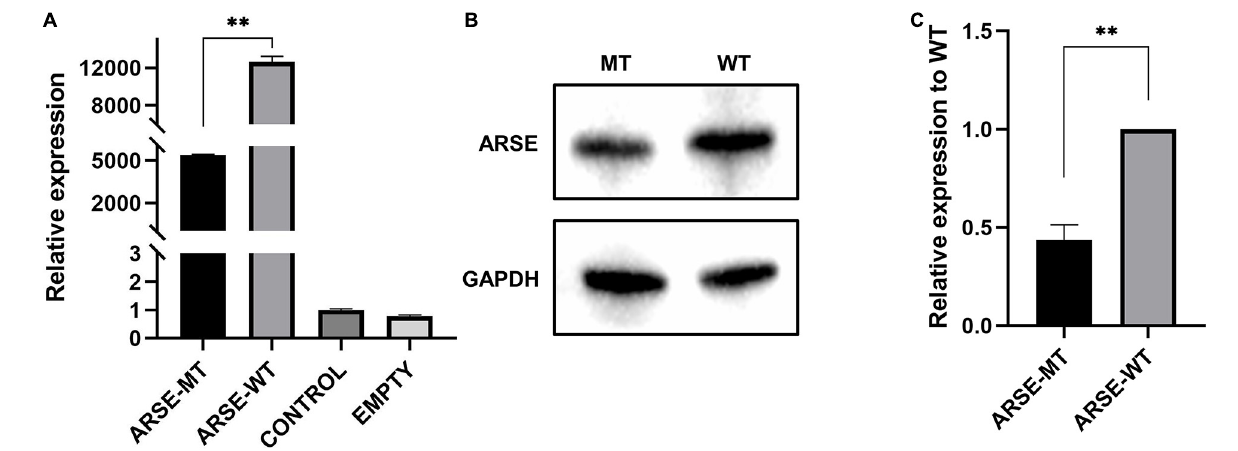
FIGURE 2 | Expression analysis of wild-type and mutated ARSE. (A) Transcriptional expression analysis of wild-type and mutated ARSE shows the decrease transcriptional level of this mutation. (B) The target band integration diagram demonstrates the same molecular weight between wild-type and mutated ARSE and the decreased expression level of mutated protein. (C) The relative expression level of mutant protein obtained after normalization of wild-type protein expression level, which indicates the low expression level of mutated protein. Statistical analysis was performed by GraphPad Prism. ARSE-WT, wild-type ARSE; ARSE-MT, mutated ARSE; EMPTY, empty plasmid vector group; CONTROL, blank-control of 293T cells. The difference between ARSE-WT and ARSE-MT is tested by Student’s t -test. ∗∗ p <